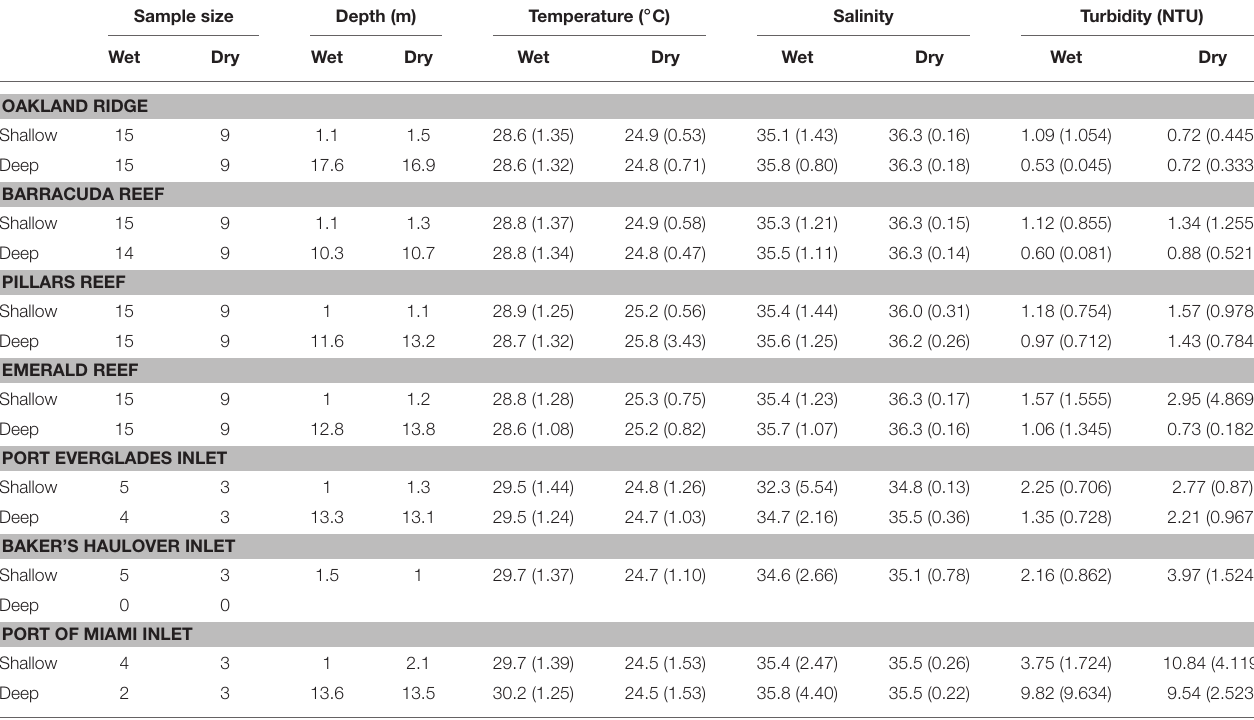
TABLE 1 | Environmental conditions and sample sizes at four reef and three inlet sites off of southeast Florida. Sample size